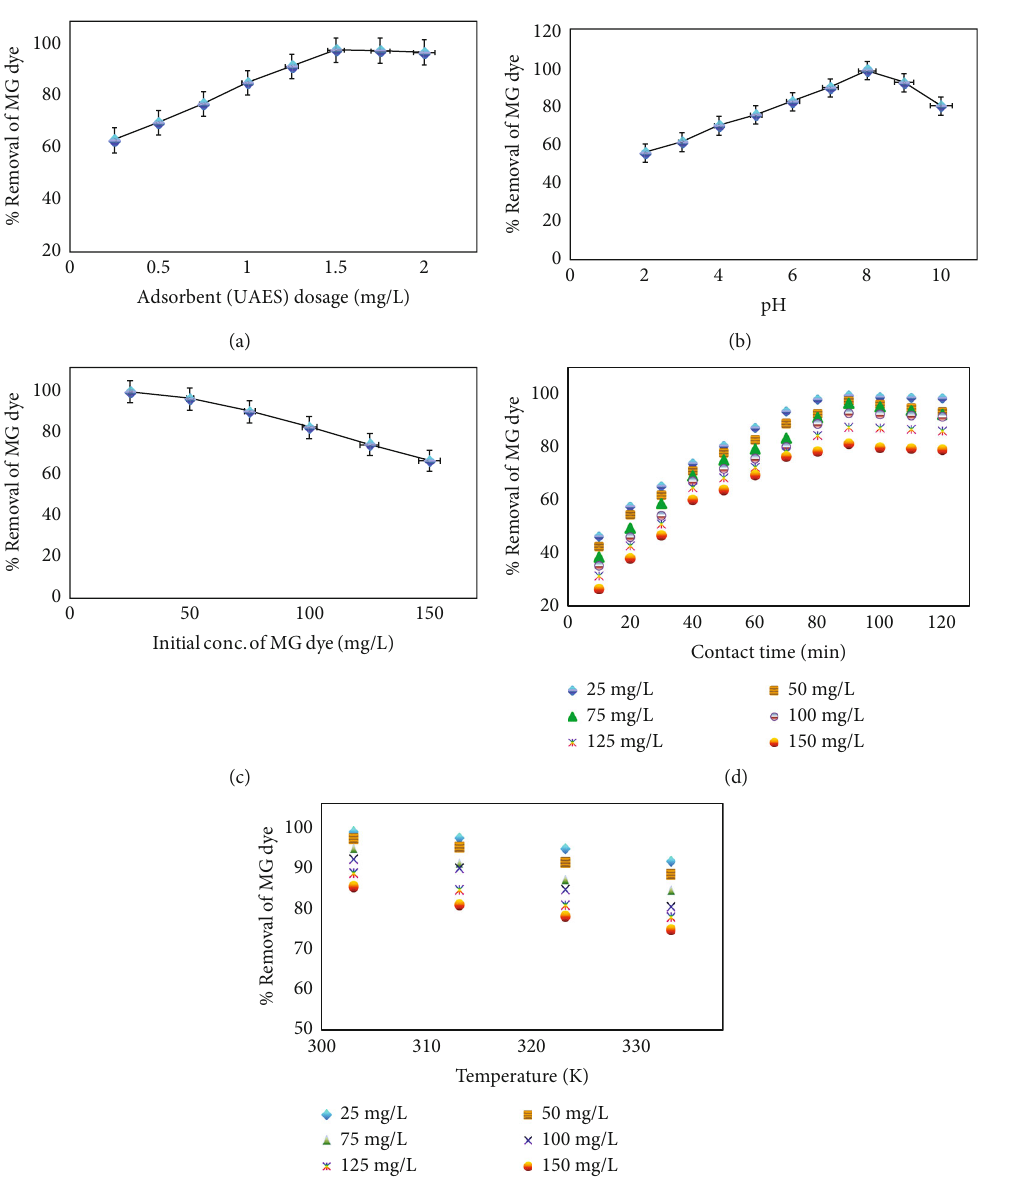
Figure 4: (a) Impact of adsorbent (UAESP) dosage on MG dye adsorption. (b) Impact of solution pH on MG dye adsorption. (c) Impact of Initial MG dye concentration on MG dye adsorption. (d) In fl uence of contact time on the adsorption of MG dye. (e) In fl uence of Temperature on the adsorption of MG